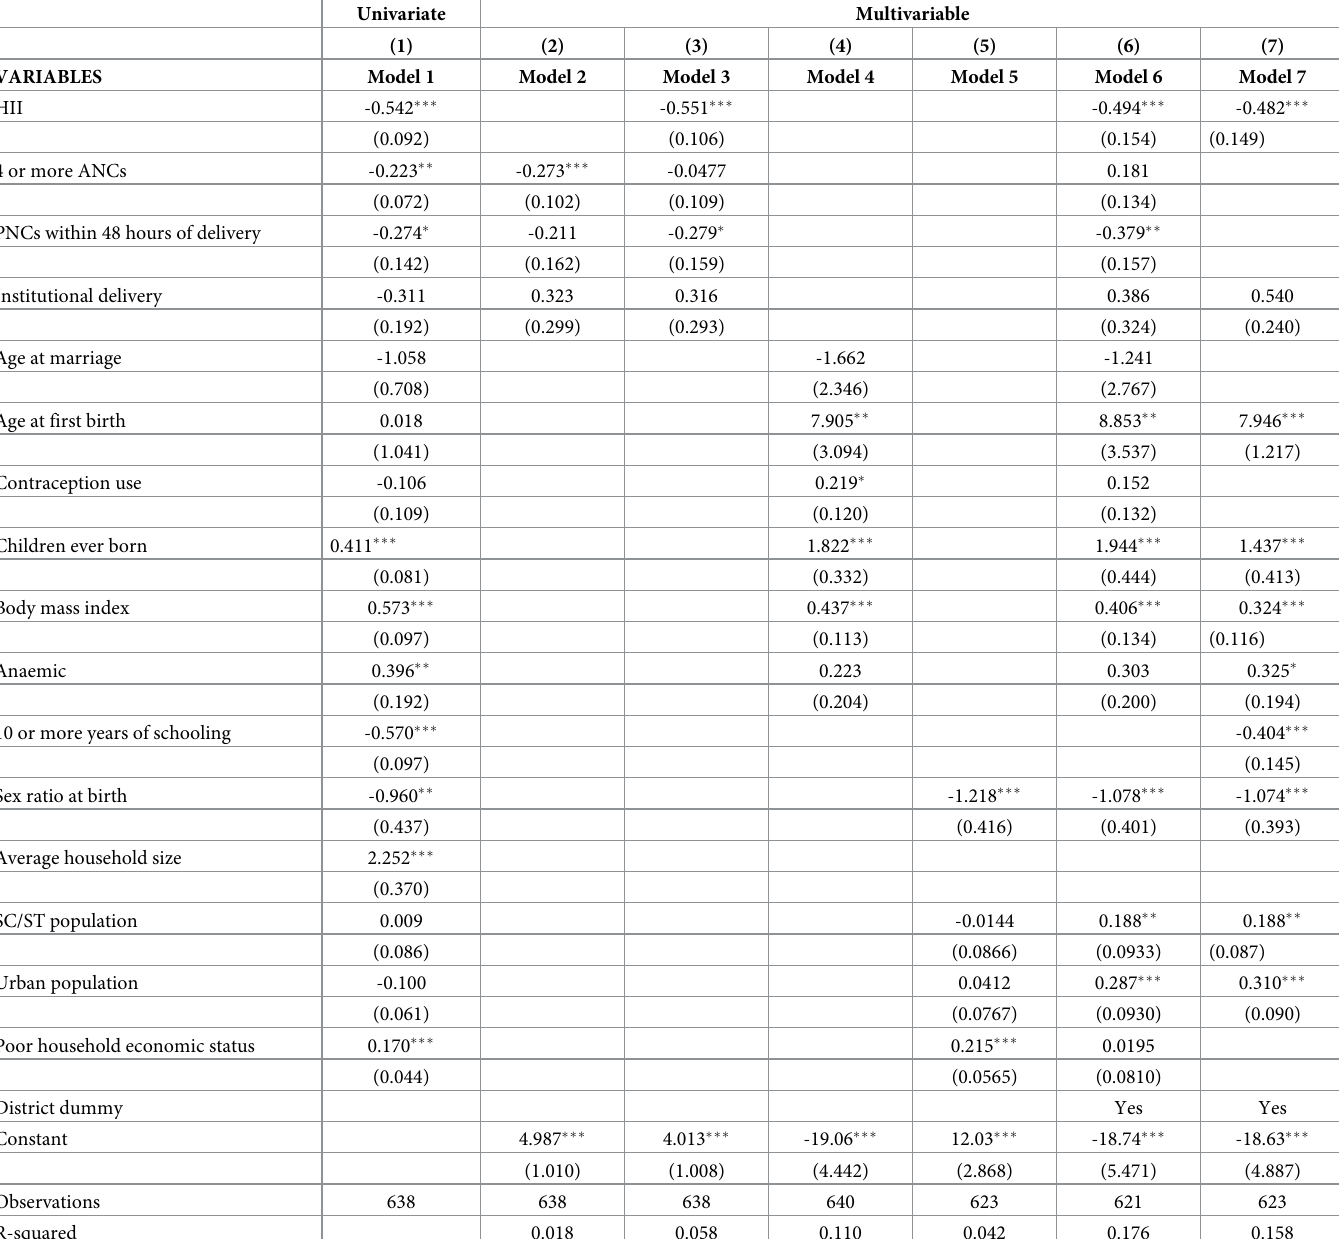
Table 3. Log-linear regression estimates: Correlates of maternal mortality ratio in